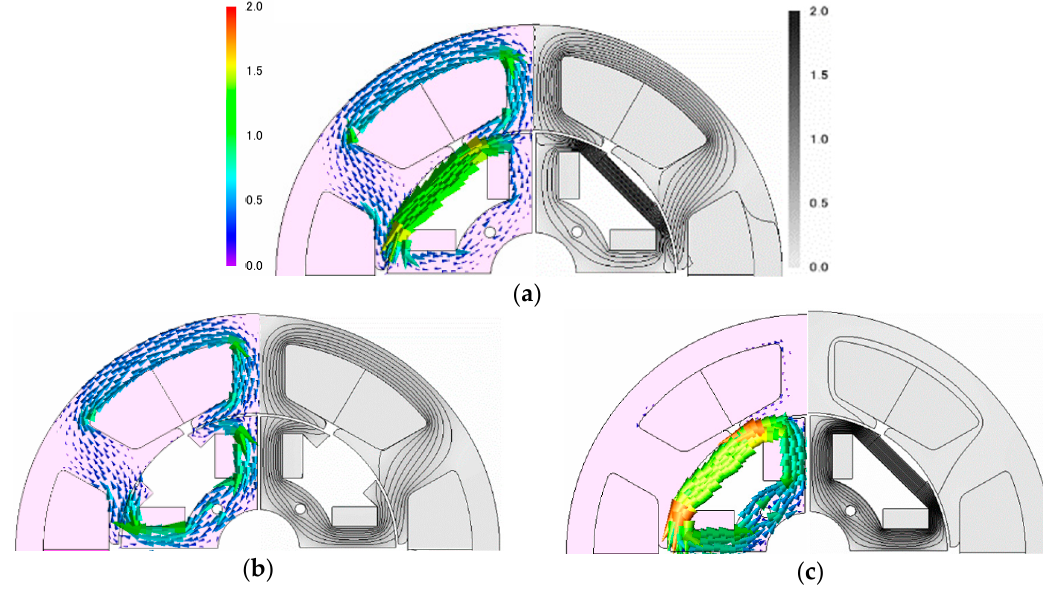
Figure 5. Total and separated magnetic flux. ( a ) Total magnetic flux; ( b ) Magnetic flux produced by FWs; ( c ) Magnetic flux produced by assisted-permanent magnets (assisted-PMs).